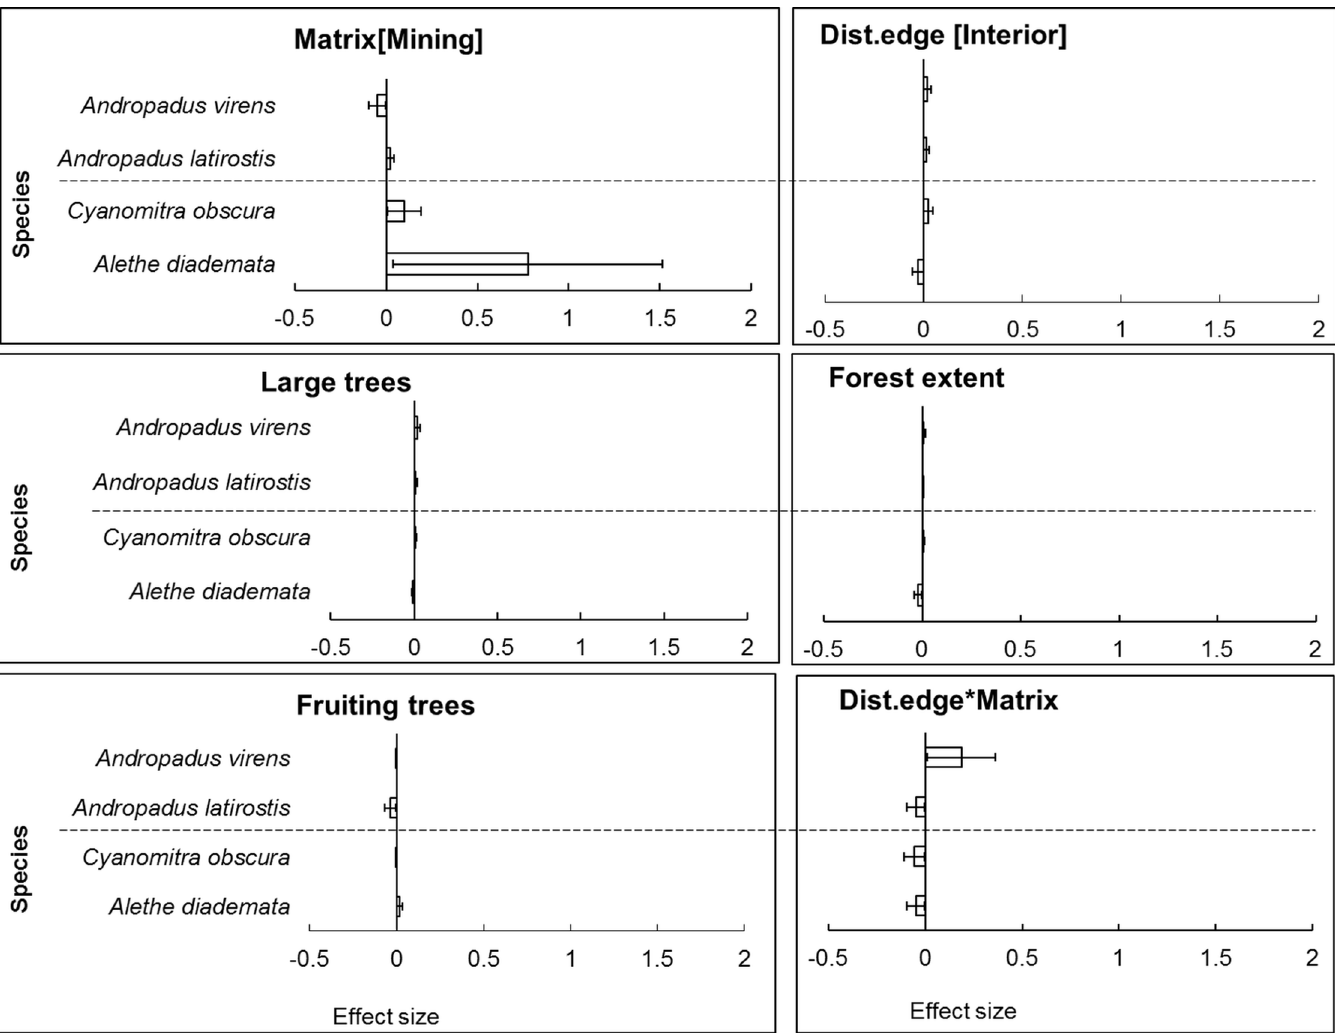
Fig 5. Model-averaged coefficients (error bar = 95% CI) of explanatory variables ’ influence on H/L ratio of all case study species. Generalist above the horizontal dashed line and specialists below in each panel.